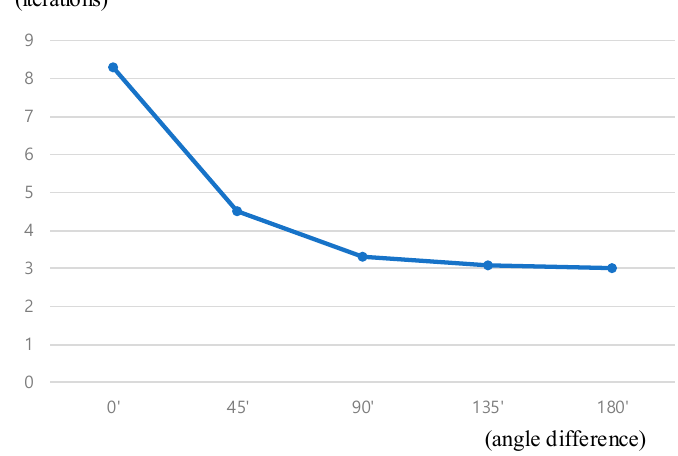
Figure 11. Iterations required for the convergence a ff ected by the direction di ff erence of moving object and camera.